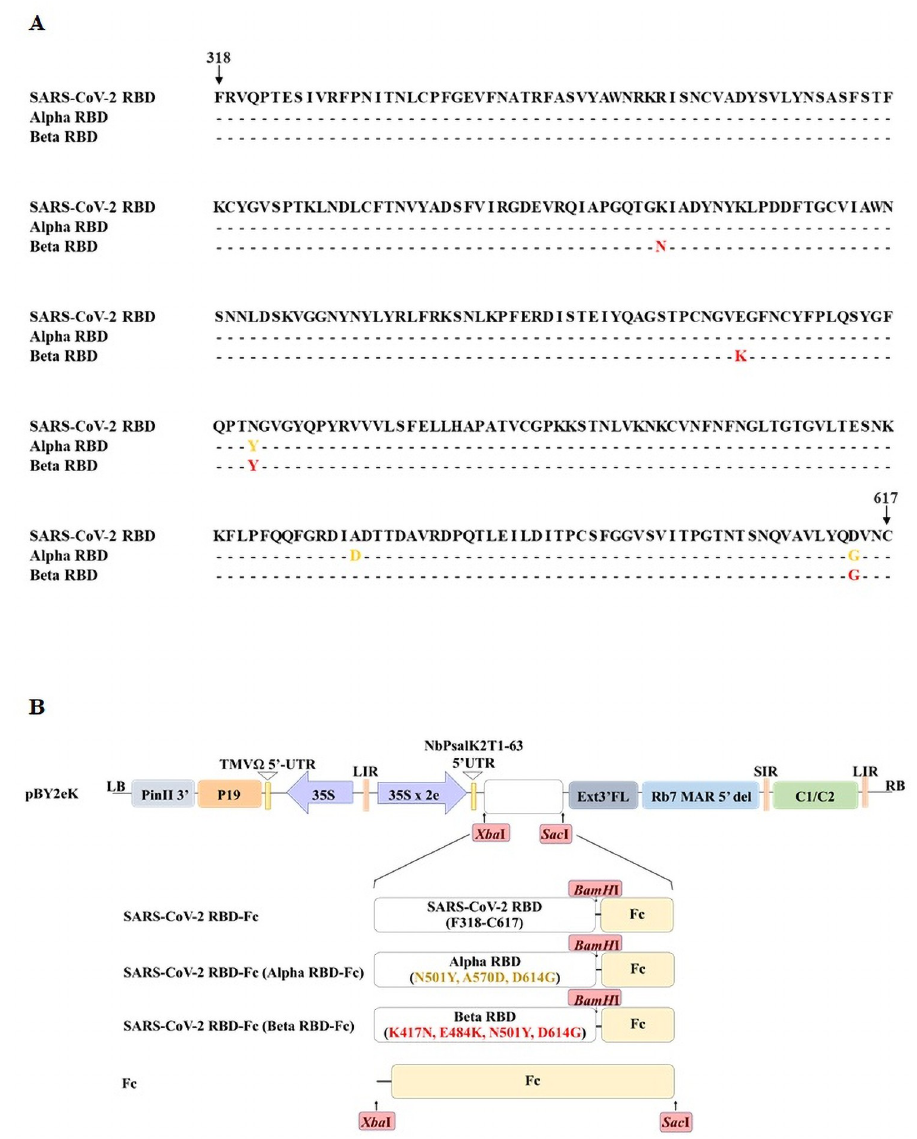
Fig 1. Amino acid sequence alignment of SARS-CoV-2, Alpha, and Beta RBDs and schematic representation of gene constructs in pBY2eK. (A) Amino acid alignment of SARS-CoV-2 RBD, Alpha RBD, and Beta RBD. Yellow and red color indicates amino acid mutation in Alpha RBD and Beta RBD, respectively. (B) Schematic representation of pBY2eK vector. T-DNA regions of the pBY2eK vector consists of P35S (cauliflower mosaic virus (CaMV) 35S promoter), NbPsaK2T 5’UTR (5 0 untranslated region), Ext3 0 FL (3 0 full length of the tobacco (Nicotiana tabacum) extension gene), Rb7 MAR 5’ del (tobacco RB7 promoter), SIR (short intergenic region of BeYDV genome), LIR (long intergenic region of BeYDV genome), C2/C1 (bean yellow dwarf virus (BeYDV) open reading frames C1 and C2 encoding for replication initiation protein (Rep) and RepA), P19 (P19 gene from tomato bushy stunt virus (TBSV)), TMV Ω 5’-UTR (5’ untranslated region of tobacco mosaic virus Ω ), and PinII 3 0 (terminator from potato proteinase inhibitor II gene). The SARS-CoV-2 RBD-Fc or Alpha RBD-Fc or Beta RBD-Fc or Fc gene was inserted into the pBY2eK ( Xba I and Sac I enzyme